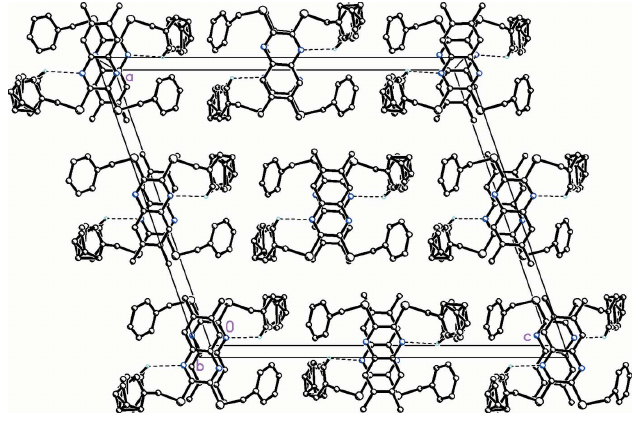
Figure 2 Packing of the title compound viewed along the b axis. The weak C15— H15 (cid:3)(cid:3)(cid:3) N1 intramolecular interactions (Table 1) are drawn as dashed lines. Hydrogen atoms not involved in the packing are removed for clarity.